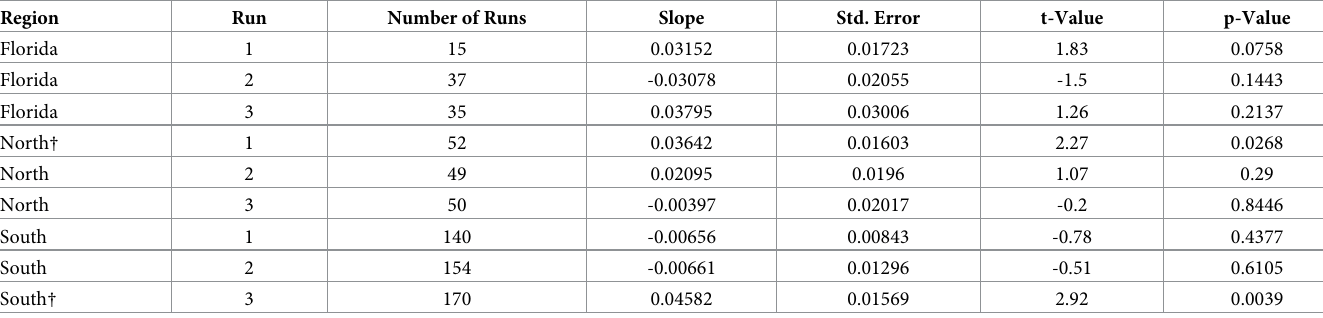
Table 9. Slope of mean species richness change for region-runs from 2000 to